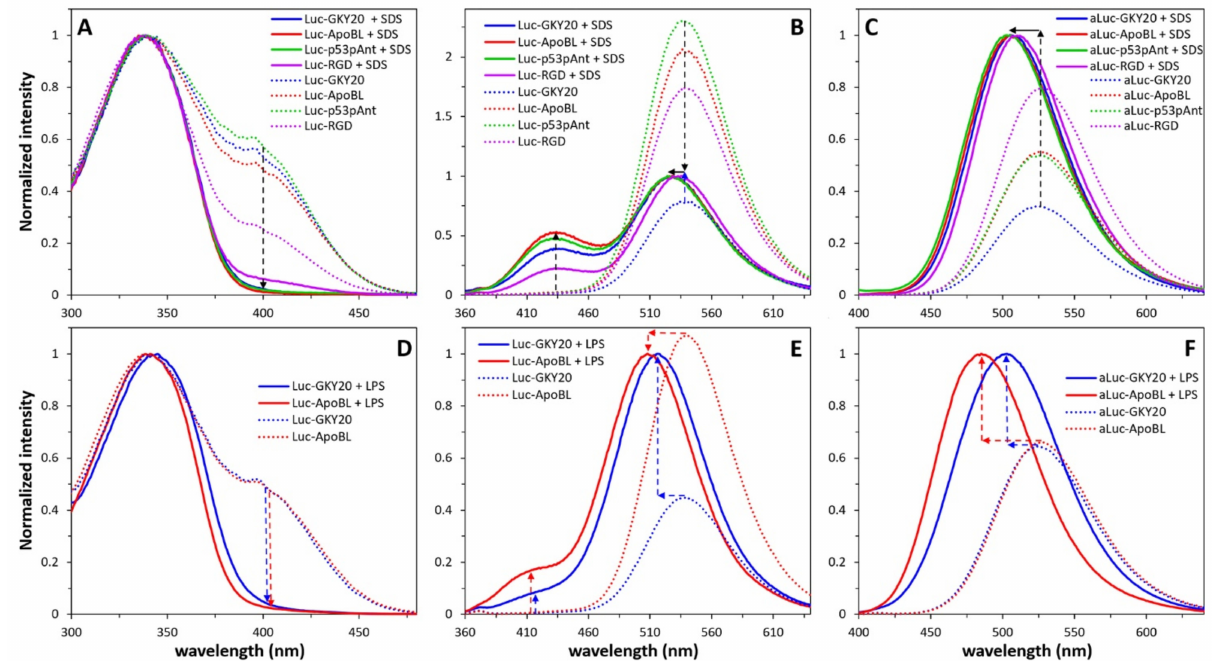
Figure 3. Fluorescence of labeled peptides in the presence of SDS or LPS micelles. ( A , D ) Excitation spectra of Luc-labeled peptides (em. = 539; Luc-GKY20 + LPS, em. = 516 nm; Luc-ApoBL + LPS, em. = 508 nm). ( B , E ) Emission spectra of Luc-labeled peptides (ex. = 330 nm). ( C , F ) Emission spectra of aLuc-labeled peptides (ex. = 363 nm). Solid line, spectra recorded in the presence of SDS or LPS; dotted line, spectra recorded in NaP. In ( B , C , E , F ), spectra recorded in NaP were normalized to the corresponding spectra recorded in the presence of SDS or LPS. Arrows highlight the main changes with respect to